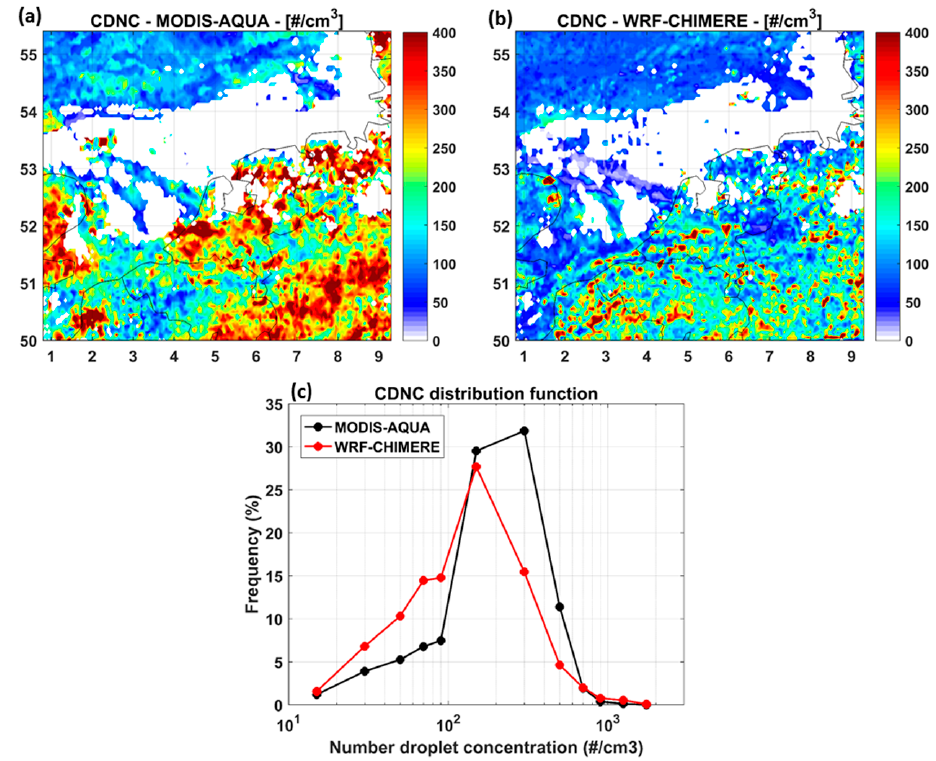
Figure 8. Panels ( a , b ) show the trimeans of cloud droplet number concentration (CDNC) retrieved by MODIS-Aqua and that calculated by WRF-CHIMERE, respectively. Panel ( c ) reports the observed CDNC distribution and CDNC distribution functions.